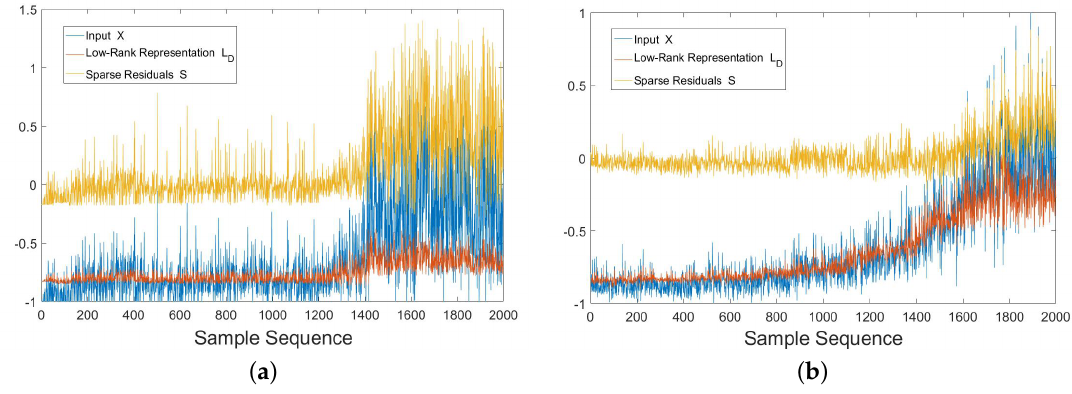
Figure 14. Decomposition results of the first feature extracted by RDA on ( a ) Source 1 and ( b ) Source